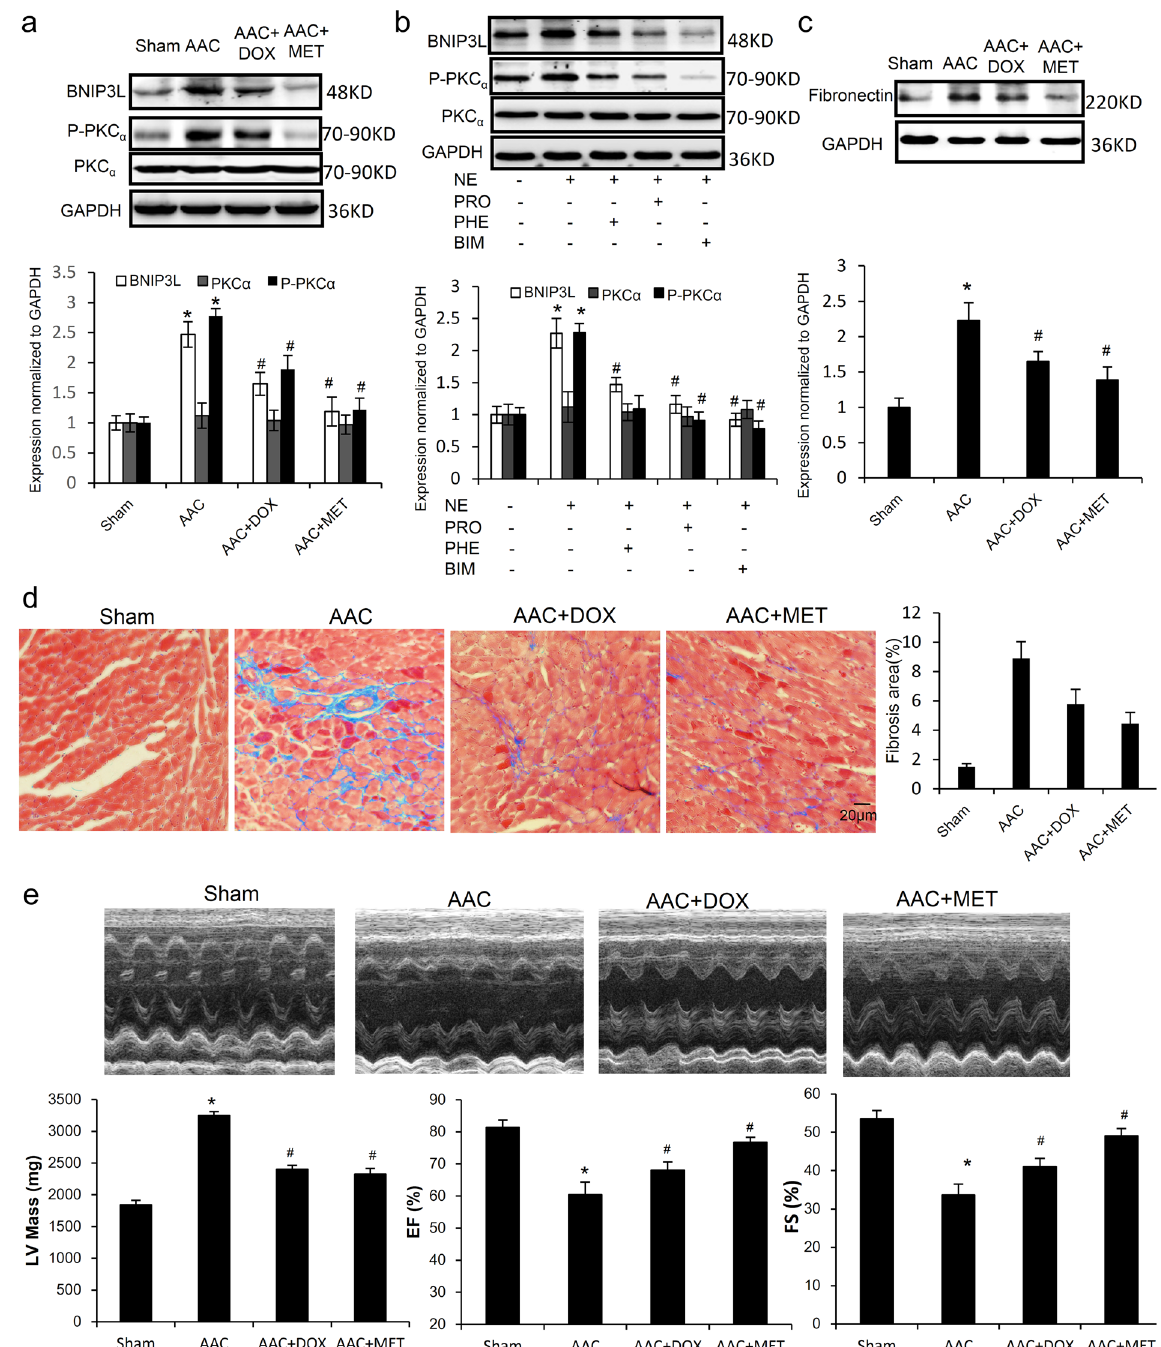
Figure 8. BNIP3L expression was up-regulated by the NE-AR-PKC signaling pathway. ( a ) Western blot analysis showing the effects of doxazosin (DOX) and metoprolol (MET) on AAC-induced BNIP3L. ( b ) Western blot analysis showing the effects of propranolol (PRO), phenoxybenzamine (PHE) and bisindolylmaleimide I (BIM) on NE-induced BNIP3L expression. ( c ) Western blot analysis showing the effects of DOX and MET on AAC- induced fibronectin expression. ( d ) Masson’s trichrome staining showing the effects of DOX and MET on AAC- induced cardiac fibrosis ( * P < 0.05 vs. sham, # P < 0.05 vs. AAC). ( e ) Echocardiographic assessment showing the effects of DOX and MET on AAC-induced cardiac dysfunction (n = 8, * P < 0.05 vs. sham, # P < 0.05 vs.